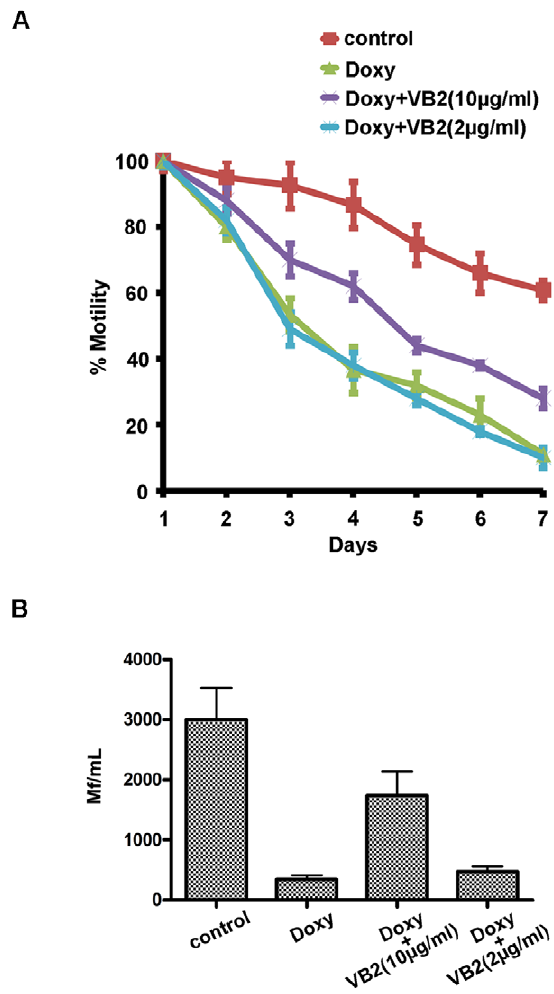
Figure 9. Vitamin B2 improved motility of B.malayi worms and microfilarial production following doxycycline treatment. Adult female B. malayi were cultured in the absence (control) or presence of 0.5 m M doxycycline, or antibiotic supplemented with either 2 m g/mL or 10 m g/mL vitamin B2. The motility of worms in vitro was examined daily for 7 days (A). Microfilariae production was determined at day 7 by counting the number of microfilaria present in 1 mL spent culture medium (B). Data obtained from triplicate samples (4 worms in each sample) are expressed as a mean 6 standard deviation.